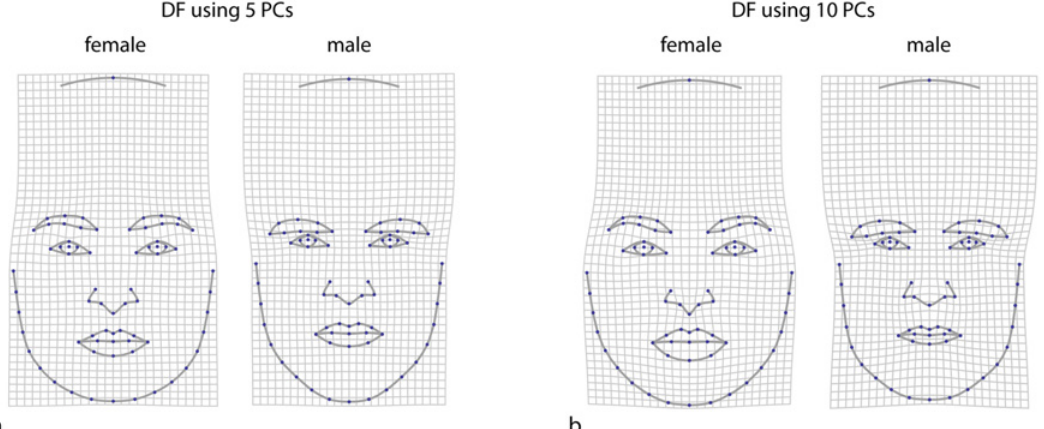
Fig 6. Visualization of discriminant functions between male and female face shapes using (a) five and (b) ten principal components (PCs) of the full set of shape coordinates.